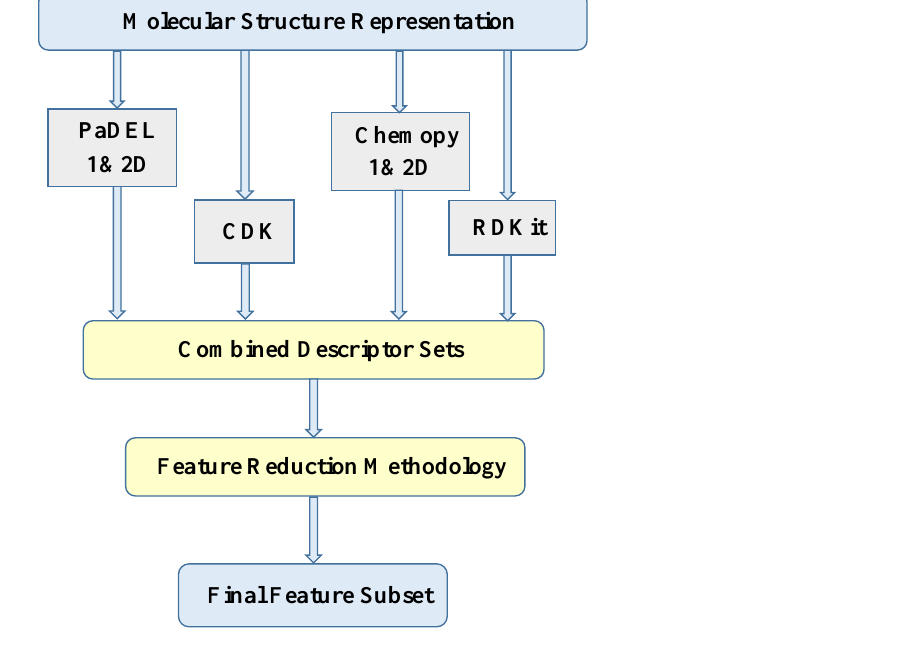
Figure 2. Combining individual descriptor sets.